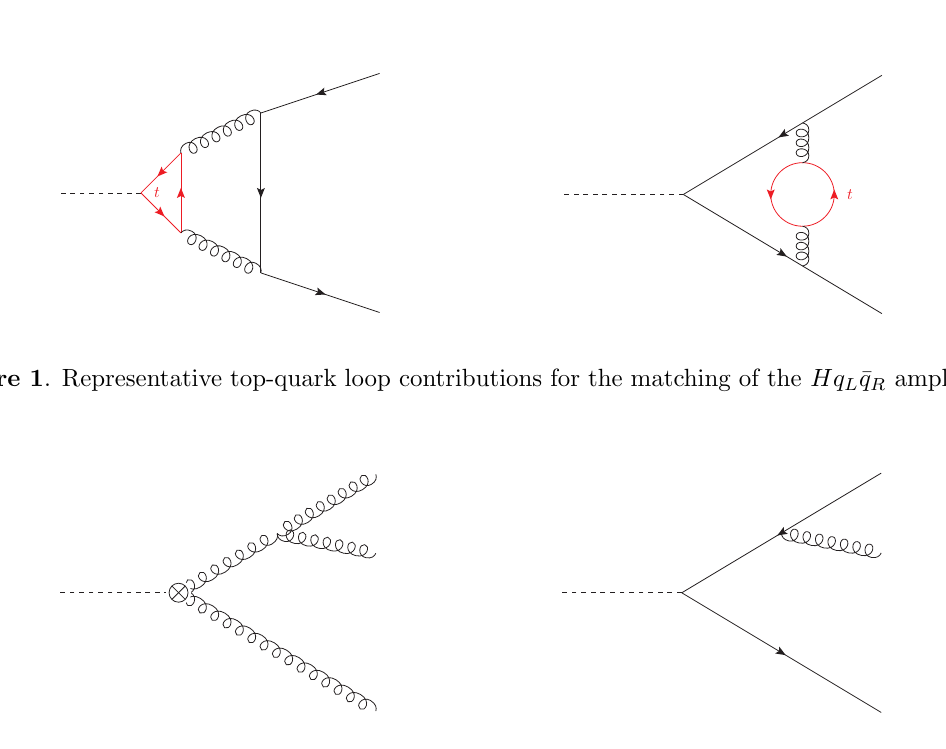
Figure 2 . Representative Feynman diagrams for the Hgg channel (left) and the Hq (cid:22) q channel (right) for the thrust distribution at